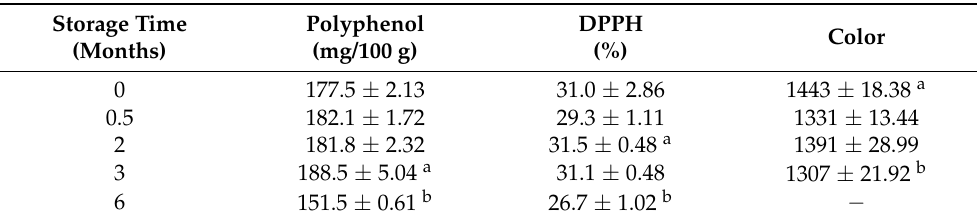
Table 6. Polyphenol content, DPPH activity, color of macerate depending on the storage time at refrigeration temperature (4 ◦